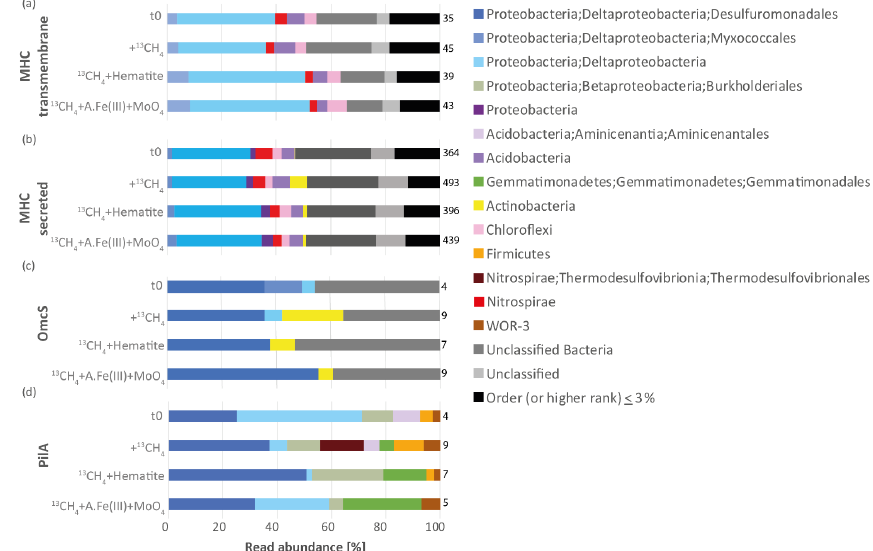
Figure 4. Taxonomic affiliation of open reading frames that are needed for extracellular electron transfer, and their relative abundances based on the read mapping. (a) Transmembrane multiheme c-type cytochromes (MHCs), (b) secreted MHC, (c) outer-membrane hexaheme c-type cytochrome (OmcS), and (d) fimbrial protein PilA. Numbers of total reads per million reads mapped to a gene according to the treatments are listed on the right side of each bar plot. A.Fe(III) + MoO 4 : amorphous iron and molybdate. We note that the taxonomy of several lineages here is based on the NCBI classification and differs from that of the Genome Taxonomy Database (GTDB). In particular, Deltaproteobacteria have been reclassified in the GTDB; thus the Desulfuromondales lineages described here belong to the phylum Desulfobacterota and class Desulfuromonadia, and Myxococcales to the phylum Myxococcota. The phylum Nitrospirae is reassigned as Nitrospirota, and the order Betaproteobacteriales as Burkholderiales in Gammaproteobacteria.